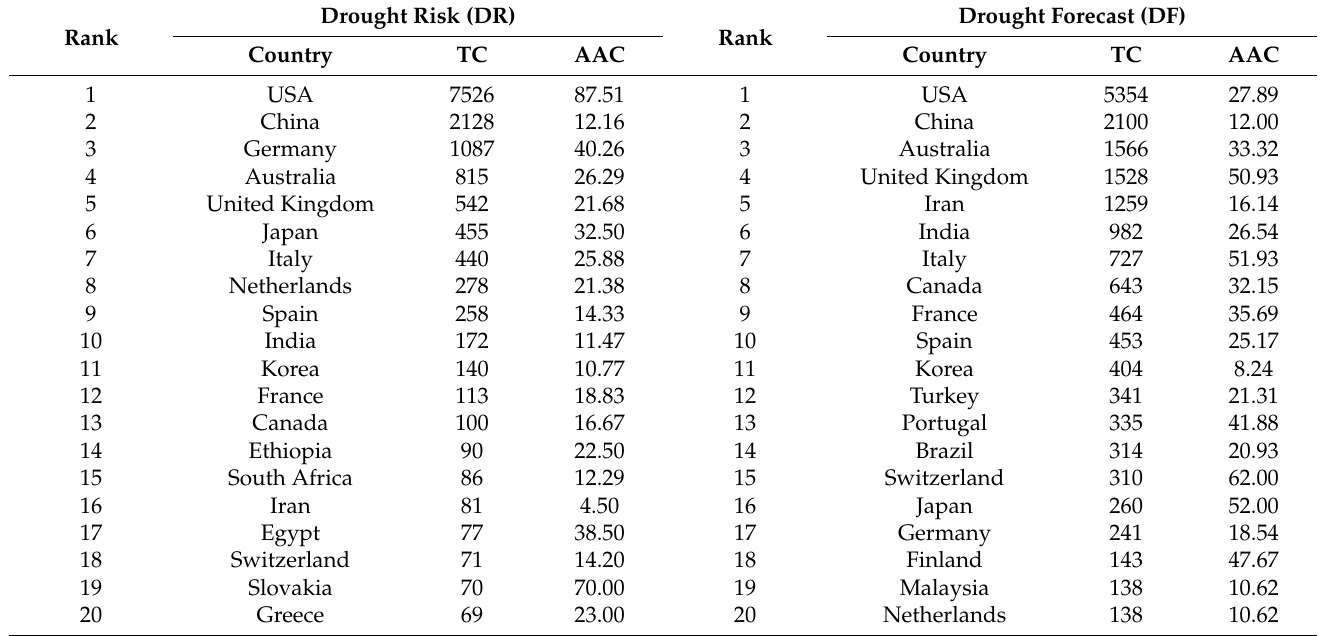
Table 4. Total citations per country in DR and DF